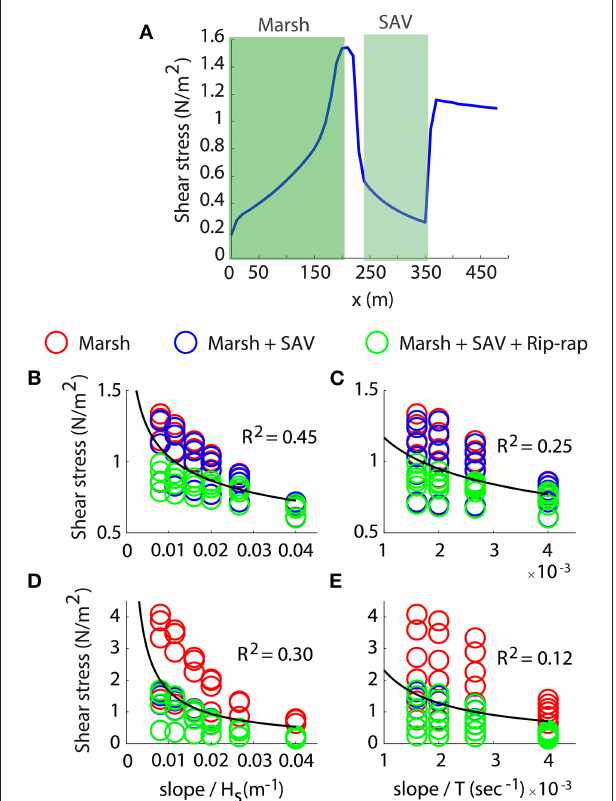
FIGURE 7 | (A) Example of shear stress along the longitudinal direction for the simulation with both vegetation communities but no rip-rap, H s 4s, and slope 0.8%. (B) Shear stress value at the beginning of the marsh ( x = 200m) for the slope 0.8%, as functions of the variable slope/Hs and (C) = = slope/T . (D) Average shear stress value within the SAV bed for the slope 0.8%, as functions of the variable slope/Hs and (E) slope/T